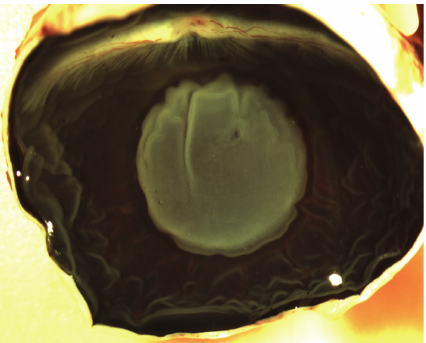
Figure 1: Appearance of the retinal detachment in the rabbit eye at seven days. The area of detached retina beneath the medullary rays appears grey and is surrounded by the darker attached retina. The detached retina contains a small hole where the micropipette was inserted. The retinal folds in the periphery occurred during the removal of the anterior